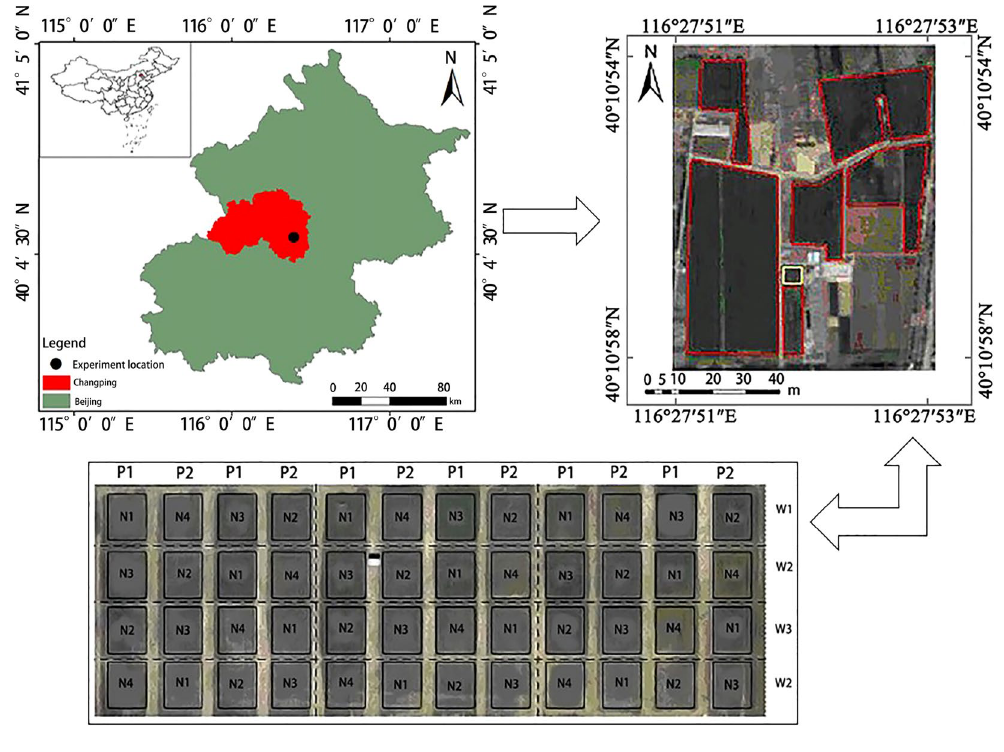
Figure 1. Study area and experimental